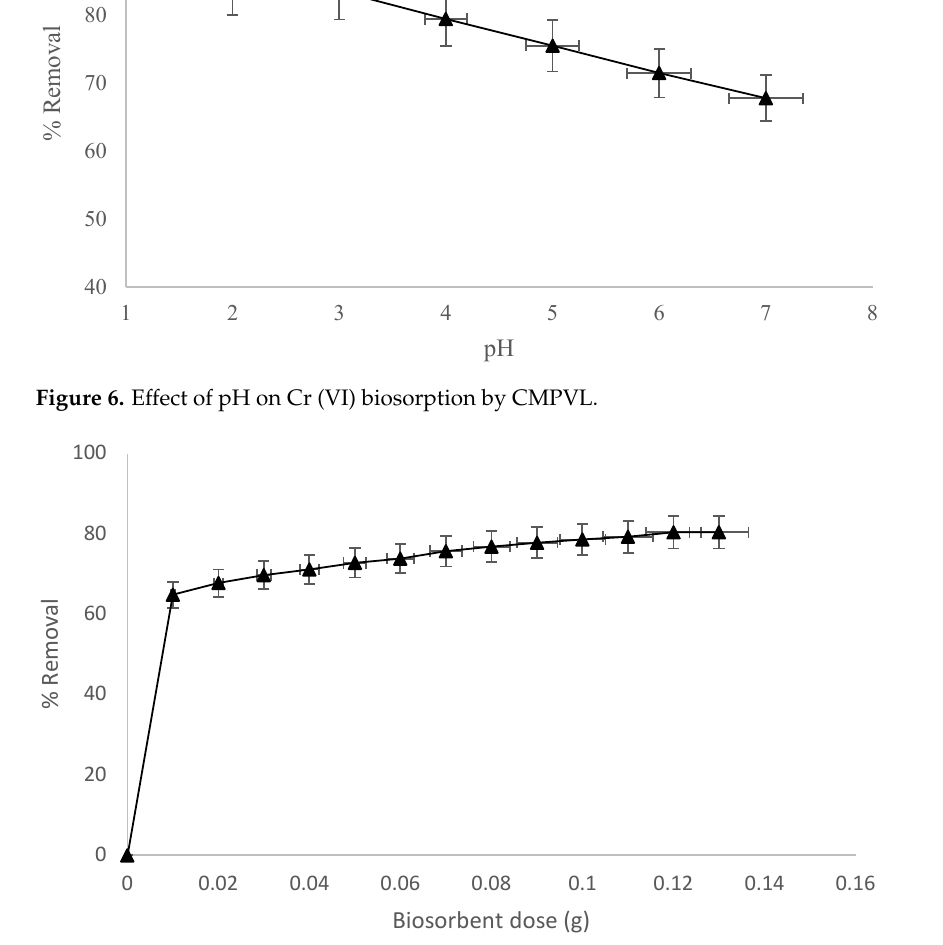
Figure 6. Effect of pH on Cr (VI) biosorption by CMPVL.